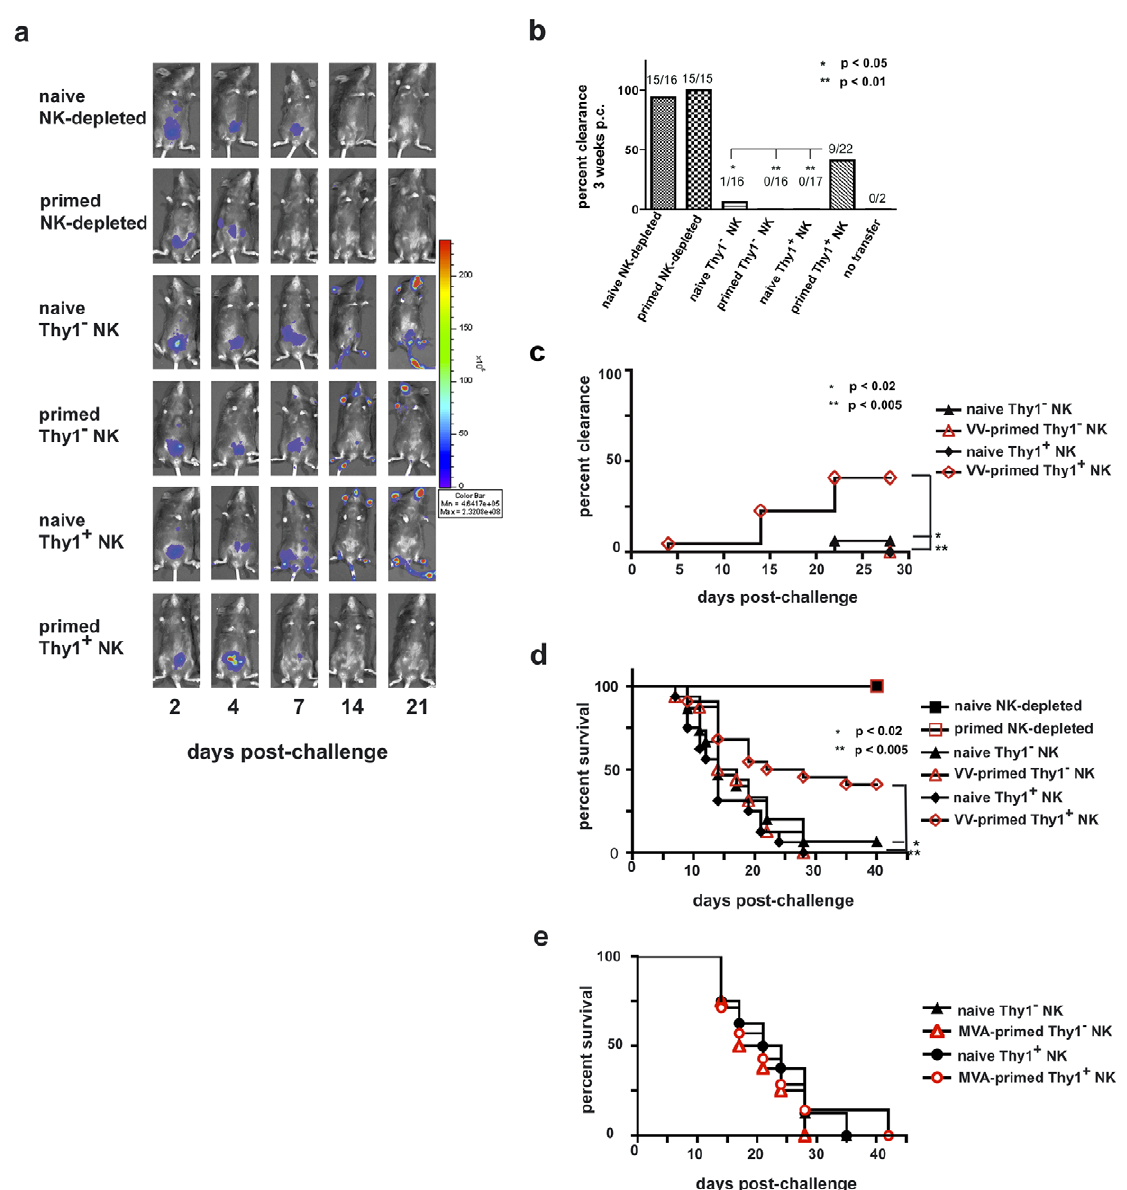
Figure 7. Innate immune protection against a vaccinia virus challenge is conferred on naı¨ve RAG1 ko mice by the adoptive transfer of primed Thy1 + liver-resident NK cells. Six months after priming, 1 6 10 5 Thy1 + liver NK cells, 1 6 10 5 Thy1 2 liver NK cells, or 5 6 10 6 NK cell- depleted liver mononuclear cells from vaccinia virus-primed or naı¨ve mice were adoptively transferred into RAG1 ko mice. At the same time, mice were administered either control immunoglobulins (those mice that received NK-depleted cell transfers) or T cell-depleting monoclonal antibodies (those mice that received Thy1 - and Thy1 + NK cell transfers). One week later the mice were challenged with 1 6 10 5 pfu rVV-luc intraperitoneally, and viral loads were monitored by IVIS imaging. ( a ) IVIS images of representative mice from each group over time following challenge are shown. ( b ) The ability of RAG1 ko mice to resolve vaccinia virus infection by 3 weeks post-challenge is represented as the percent clearance within each group. Results were compiled from 4 separate experiments. RAG1 ko mice that received primed Thy1 + liver NK cells showed enhanced clearance of vaccinia virus as compared to mice that received naı¨ve Thy1 + NK cells, naı¨ve Thy1-depleted NK cells, and primed Thy1-depleted NK cells (two-tailed Fischer test between groups). All statistics compare the test group relative to the group that received primed Thy1 + liver-resident NK cells. ( c ) The ability of RAG1 ko mice to clear vaccinia virus infection throughout the course of challenge is represented as the percent clearance within each group. Results represent 4 separate experiments. RAG1 ko mice that received primed Thy1 + liver NK cells showed enhanced protection against vaccinia virus challenge as compared to mice that received naı¨ve Thy1 + NK cells, naı¨ve Thy1 2 NK cells, and primed Thy1 2 NK cells. Statistical analysis was performed to compare Kaplan-Meier survival curves using GraphPad Prism 4 software. All statistics compare the test group relative to the group that received primed Thy1 + liver-resident NK cells. Protection provided by transferred primed Thy1 + hepatic NK cells surpassed the protection observed in mice that received hepatic naı¨ve Thy1 2 NK cells (using the log rank test; p=0.0168), primed Thy1 2 NK cells (p=0.0043), and naı¨ve Thy1 + NK (p=0.0033). ( d ) Kaplan-Meier curves showing the survival of naı¨ve RAG1 ko recipients of the indicated adoptively transferred cell populations. Results represent the compilation of 4 separate experiments. RAG1 ko mice that received primed Thy1 + liver NK cells showed enhanced survival of vaccinia virus challenge as compared to mice that received naı¨ve Thy1 + NK cells, naı¨ve Thy1 2 NK cells, or primed Thy1 2 NK cells. Statistical analysis was performed as in (c), demonstrating that host protection provided by transferred primed Thy1 + hepatic NK cells surpassed the protection observed in